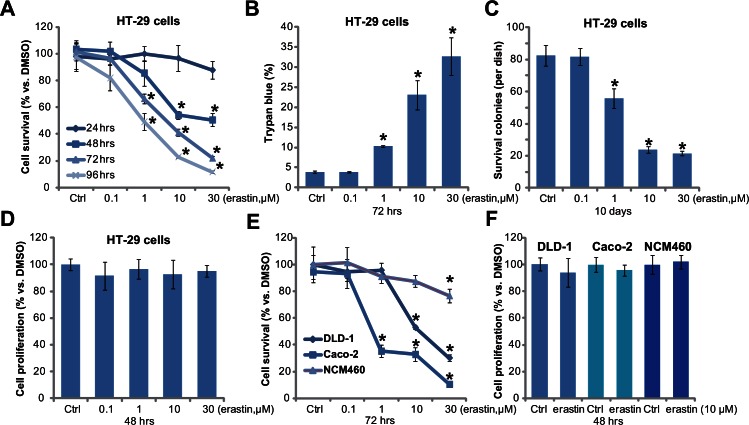
Erastin exerts cytotoxic, but not cytostatic, effects to cultured colorectal cancer cells.Colorectal cancer cells (HT-29, DLD-1 and Caco-2 lines) or NCM460 colon epithelial cells were treated with vehicle control (0.1% DMSO, “Ctrl”) or indicated concentrations of erastin for applied time, cell survival was tested by MTT assay (A and E) and colony formation assay (C); The percentage of trypan blue positive (“dead” cells) was recorded (B); Cell proliferation was tested by BrdU incorporation assay (D and F). For each assay, n = 5. The data presented were mean ± SD. Experiments were repeated three times with similar results obtained. * p < 0.05 vs. group of “Ctrl”.